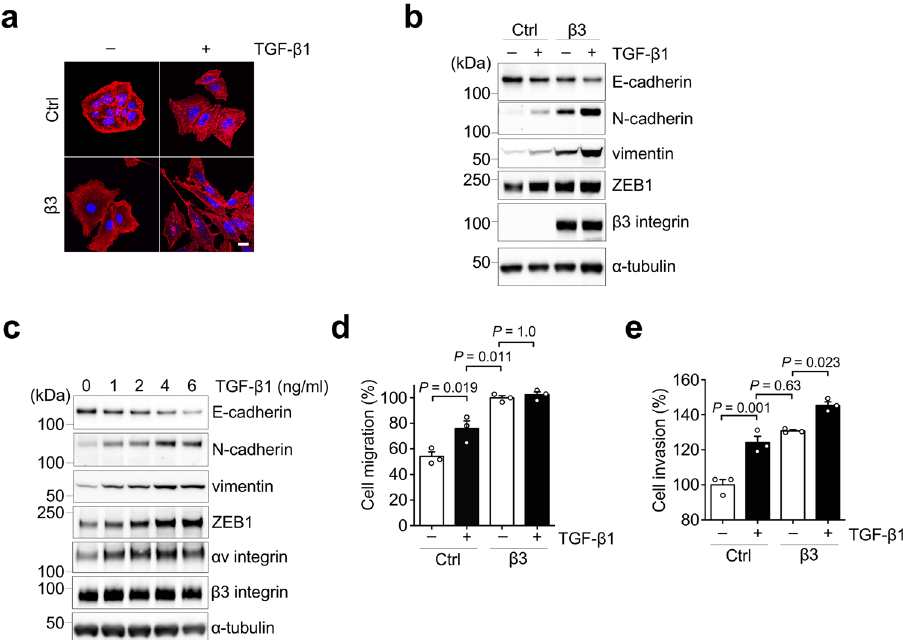
Fig. 6 Synergistic effect of α v β 3 integrin and TGF- β 1 on EMT induction. a F-actin staining (red) of control and β 3-A549 cells in the absence or presence of TGF- β 1. Images are shown with nuclear stain (blue). Scale bar, 10 µ m. b Western blotting of EMT markers in control and β 3-A549 cells in the absence or presence of 2 ng/ml TGF- β 1 for 24 h. c Western blotting of EMT markers in β 3-A549 cells treated with different concentrations of TGF- β 1. d , e Effect of TGF- β 1 treatment on the cell migration ( d ) and invasion ( e ) of control and β 3-A549 cells. One-way ANOVA and Bonferroni post-hoc test, mean ± s.e.m. of three independent assays conducted in triplicate. The source data are provided in Supplementary Data 1. Unprocessed blot images in ( b and c ) are shown in Supplementary Figs. 7 and